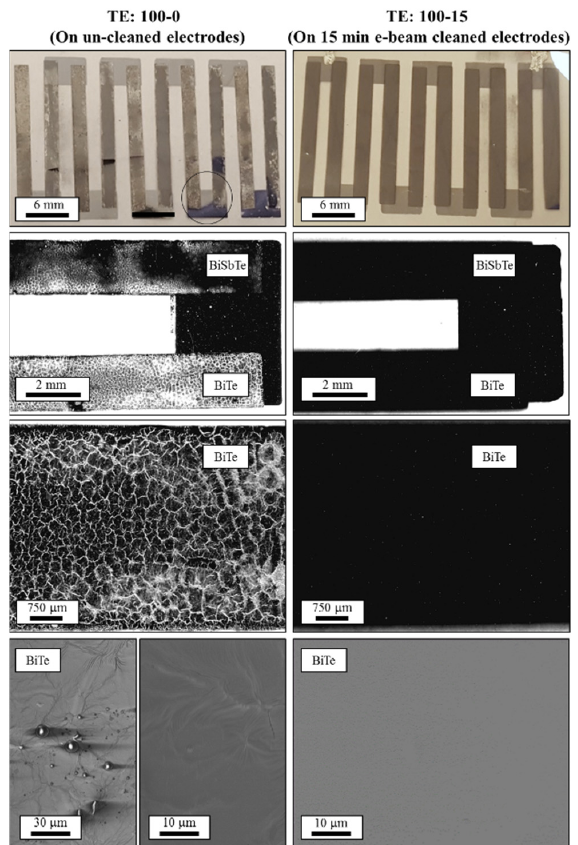
Figure 4. n-type (BiTe) and p-type (BiSbTe) semiconductors sputtered onto uncleaned patterned electrodes (TE:100-0) (left column) was impaired by residual masking oil on the PET substrate re- sulting in noncontinuous semiconductor layers. An intermediate, roll-to-roll compatible electron beam cleaning stage (right column) successfully removed residual oil for production of a pristine column) successfully removed residual oil for production of a pristine TEG (TE:100-15) to allow a TEG (TE:100-15) to allow a continuous, featureless semiconductor layer observed via optical micros- copy and SEM. continuous, featureless semiconductor layer observed via optical microscopy and